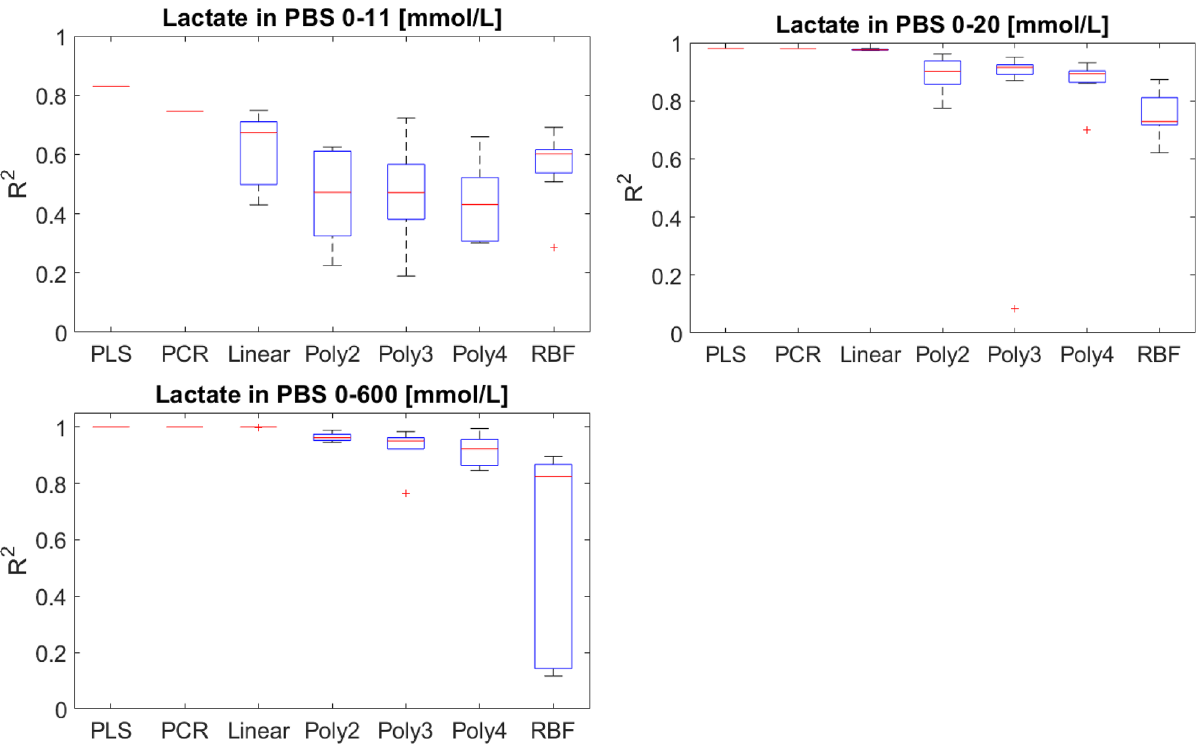
Figure 1. The comparison of the performance of linear and nonlinear models is datasets with low, medium, and high ranges of lactate concentrations. The boxplots summarise the results pertaining to ten runs of cross- validation for each model. After each run, an estimate of the coefficient of determination, R